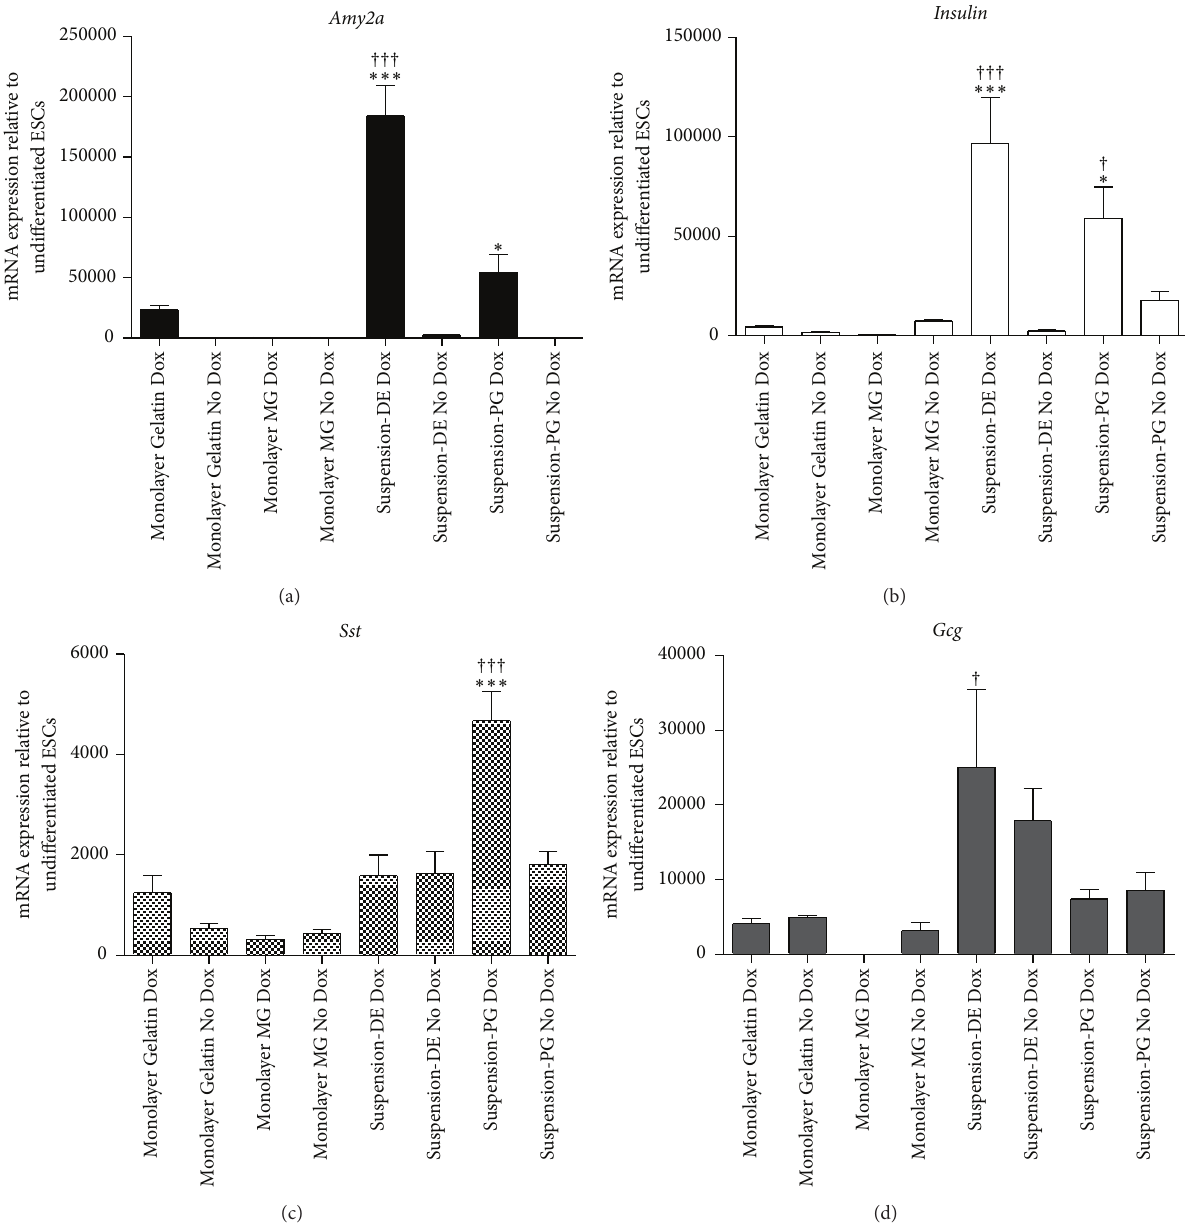
Figure 6: A short 3D culture period at the beginning of differentiation promotes PTF1a-induced pancreatic differentiation. Populations that formed EB-like floating bodies either in DE or in PG stage, when replated and subjected to the differentiation protocol, expressed significantly more Amy2a (a), Insulin (b), Sst (c), and Gcg (d) transcripts than those cultures grown as monolayers throughout. Growing in suspension also improved endocrine differentiation in general (Suspension-DE No dox and Suspension-PG No dox) indicated by elevated Insulin , Sst , and Gcg transcripts. 𝑁 = 3 . Data are presented as mean ± SEM. Asterisks indicate 𝑃 values on comparison with Gelatin-No Dox cultures: ∗ 𝑃 < 0.05 , ∗∗∗ 𝑃 < 0.001 , and Obelisks indicate 𝑃 values on comparison with Gelatin-Dox cultures: † 𝑃 < 0.05 and ††† 𝑃 < 0.001 determined by one-way ANOVA with Tukey’s multiple comparison